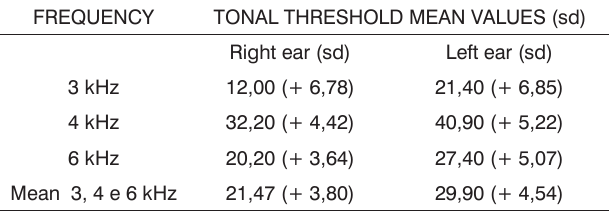
Table 1. Mean and standard deviation of the tonal thresholds in the 3, 4 and 6khz audiometric frequencies and the mean values of the three frequencies, according to ear laterality in the NIHL G.